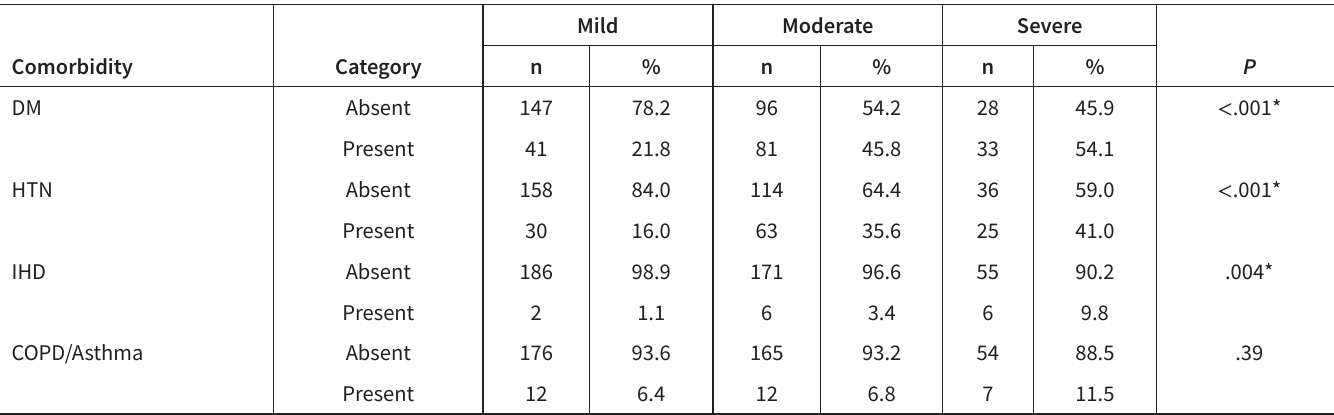
Table 5. Comparison of Clinical Severity of COVID-19 with Comorbid Conditions of Patients Using Chi-Square Test